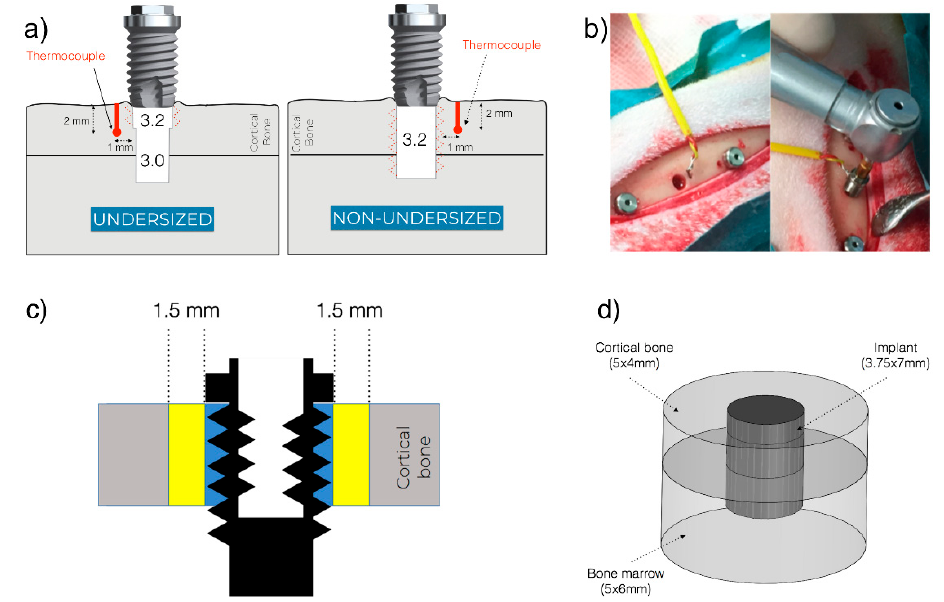
Figure 1. ( a ) Representation of the osteotomy preparation: the undersized drilling protocol on the left and non-undersized drilling protocol on the right. The osteotomy dimensions are depicted in the figures. The thermocouple site was prepared 2 mm deep into the cortical bone and 1 mm from the implant surface. ( b ) Overview of the surgical field with the thermocouple in position before implant installation ( left ) and during implant installation ( right ). ( c ) Representation of the regions of interest for histomorphometrical parameters. Bone-to-implant Contact (BIC) was calculated only for the cortical portion. Bone Area Fraction Occupancy (BAFO) was calculated in the blue part. Bone Area 1.5 (BA1.5) was calculated in the yellow part. ( d ) The Finite Element Model (FEM) was composed of three cylindrical elements: Cortical bone, bone marrow, and